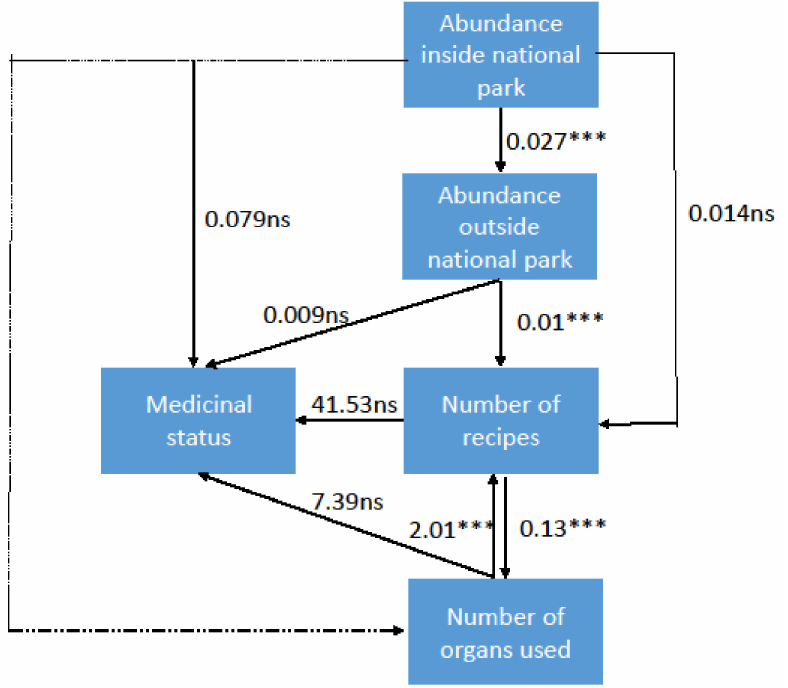
Figure 3. The most complex meta-model illustrating simultaneous influence of outside and inside plant abundance on medicinal knowledge. Different paths (arrows) of the relationships of total abundance with medicinal status are color-coded; black, direct path, green, shortest indirect path, and red, longest and most strong indirect path. The width of arrow is indicative of the strength of the relationships between two variables. Values on the arrows are path coefficients; SE, standard error. The number of stars indicates the level of statistical